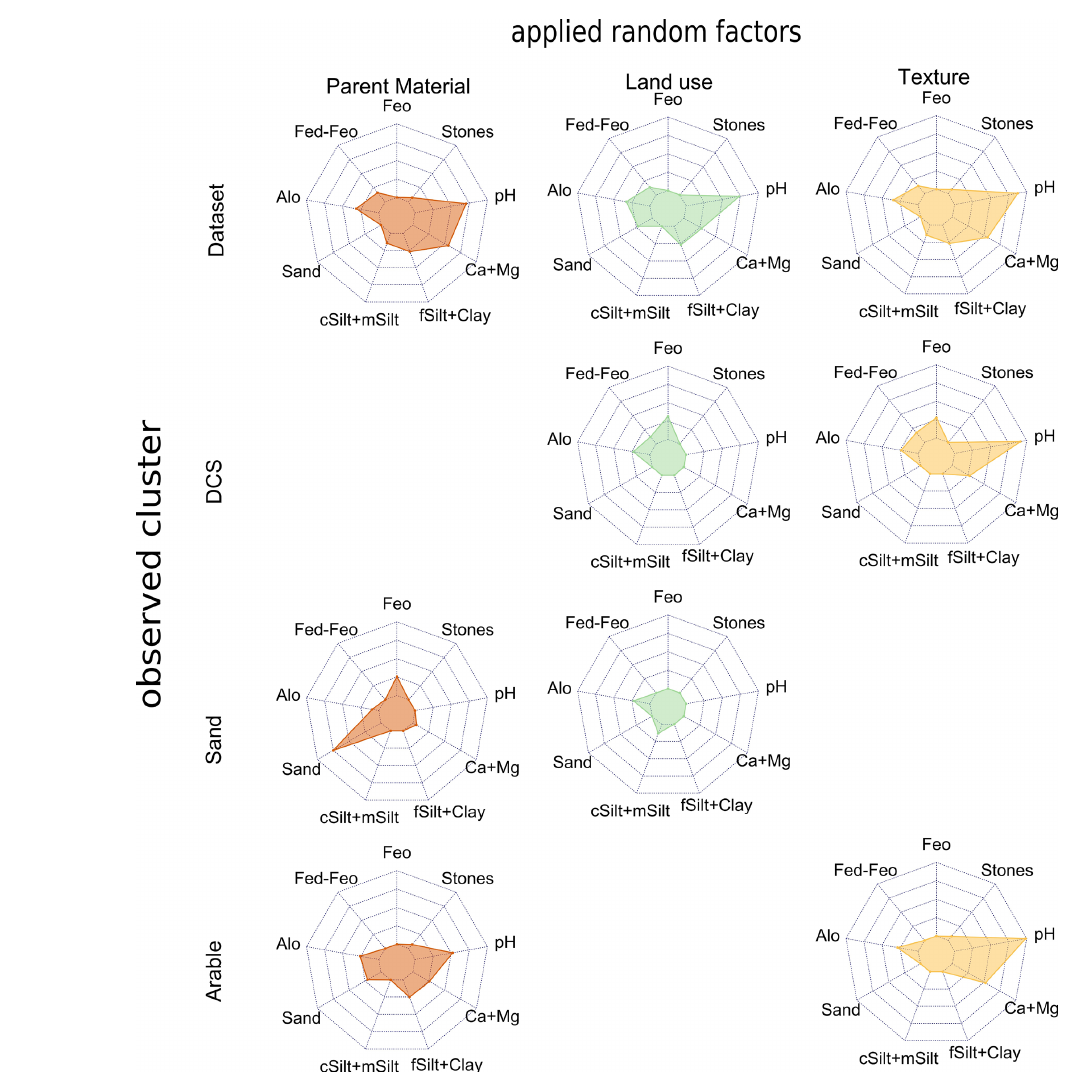
Figure 4. Coefficients of the mixed-effect models to predict SOC multiplied by the mean values of the specific cluster indicating the impact of the applied variables. Differentiation into clusters and used random factors. Variables are scaled from 0 to 1.